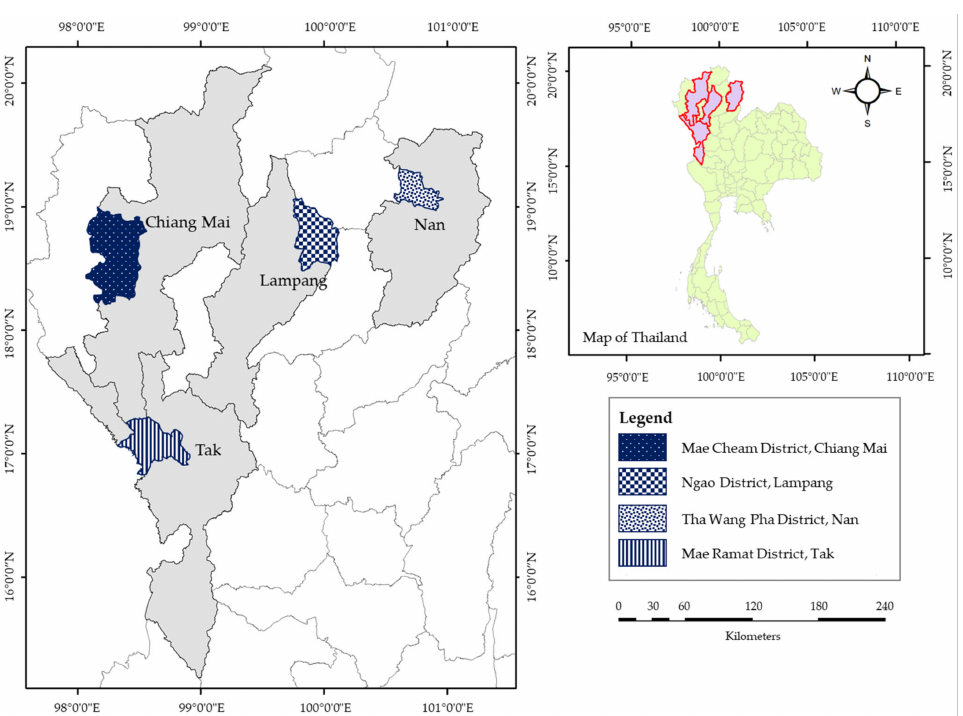
Figure 1. Map of northern Thailand highlighting the four concerned provinces. Source: